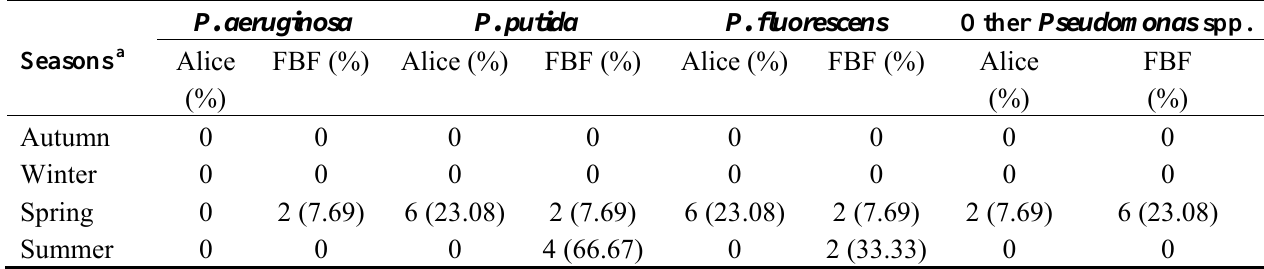
Table 3. Prevalence of Pseudomonas species in mixed liquor